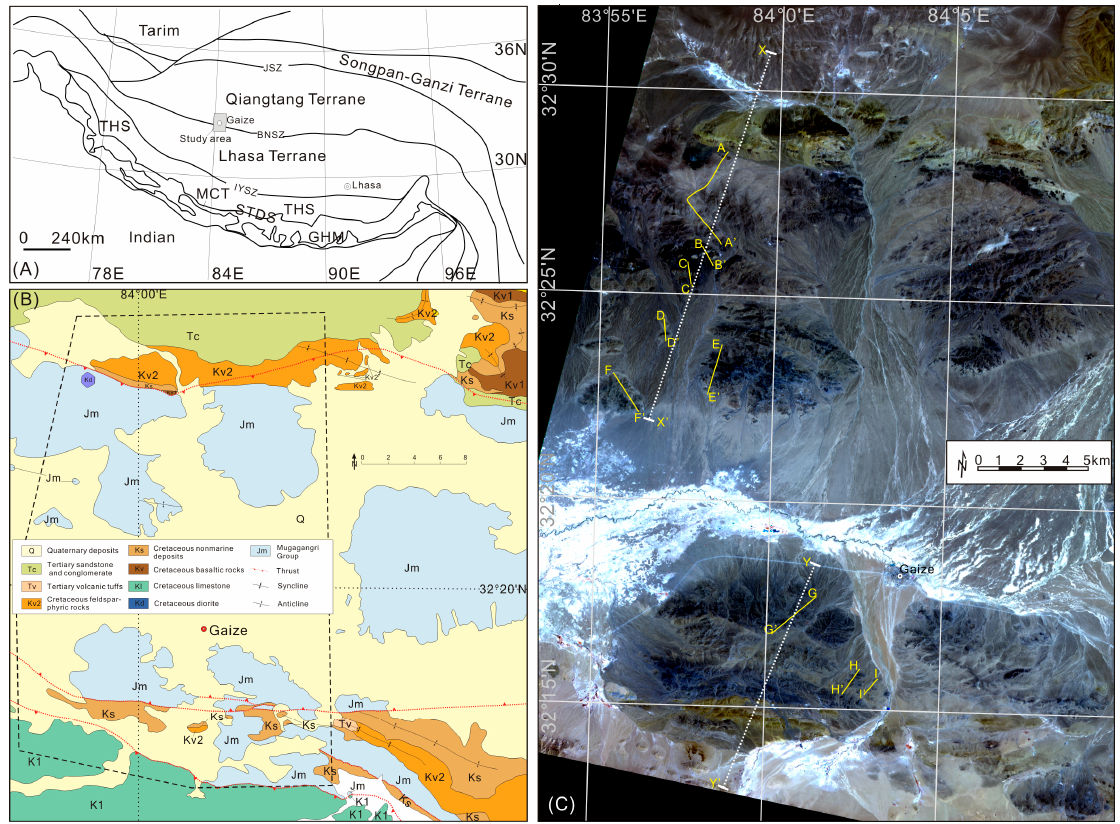
Figure 1. ( A ) Tectonic map showing terranes and suture zones of the Tibetan plateau (From [7]). The location of the study area is indicated by the dash box; ( B ) Geological map of the study area, Gaize, Tibet (Modified from [11,16,25]); ( C ) ASTER false color composite image (Red—band 3; Green—band 2; Blue—band 1) of the study area. Yellow solid lines (e.g., A–A’) indicate field-investigated sections and white dash lines (X–X’ and Y–Y’) indicate composite cross-sections constructed based on the field sections.